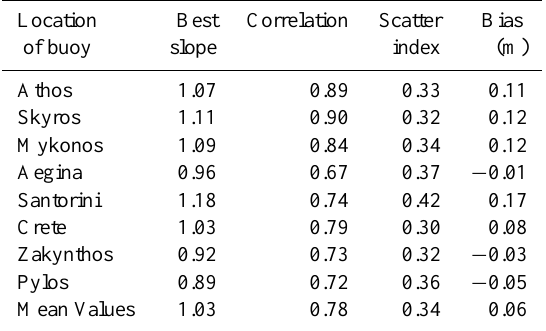
Table 2. Statistics for significant wave height from the comparison at eight buoy locations.